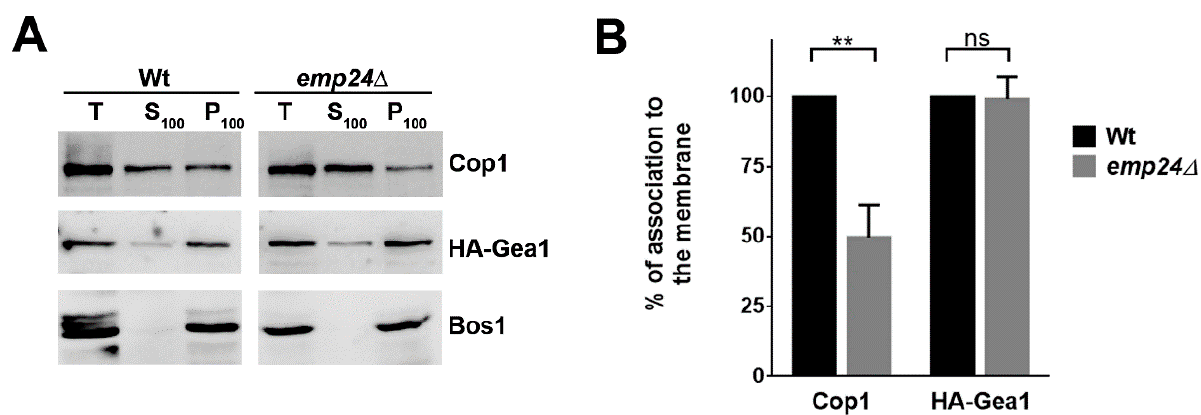
Figure 3. The absence of Emp24 reduces the Golgi membrane association for the COPI coat but not for HA-Gea1. ( A ) Golgi membrane association of Cop1 and HA-Gea1 in wild-type and emp24 ∆ strains. Total (T) lysates prepared from cells expressing HA-Gea1 were differentially centrifuged as in Figure 1. The collected soluble S100 and membrane P100 fractions were analyzed by Western blot using antisera to Cop1, HA and the SNARE Bos1, used as Golgi membrane marker. ( B ) Quantification of three independent experiments. The graph plots the average percentage of the Golgi membrane association of Cop1 and HA-Gea1 normalized to the association in the wild-type strain. Membrane association was determined by quantification of the amount of protein present in the membrane (P100) fraction divided by the amount present in both the membrane and soluble fractions (P100 + S100). Error bars indicate the SD. Statistical significance was determined by using the Student t test. ** p < 0.01.